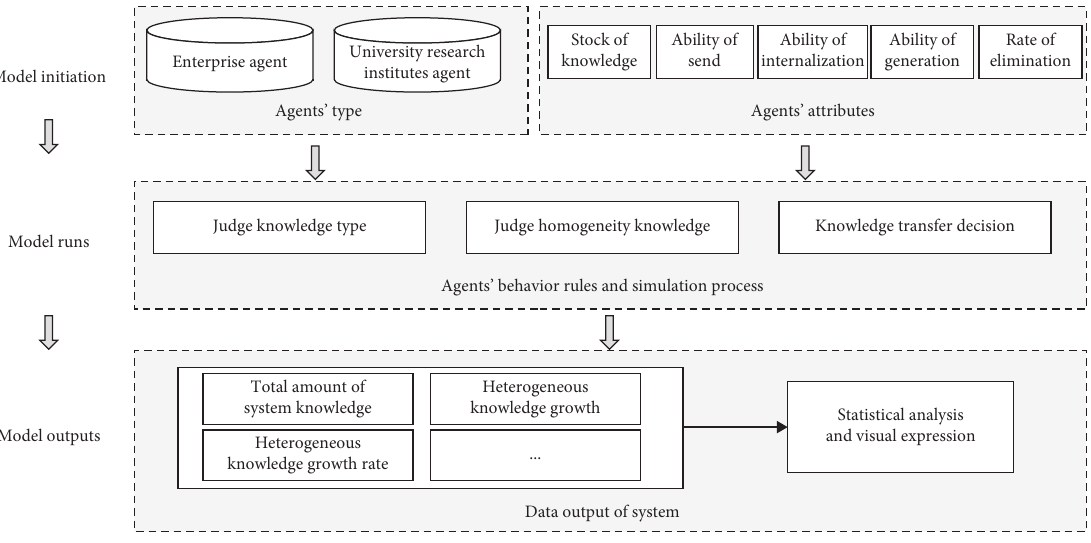
Figure 3: Simulation procedure of the agent-based model for heterogeneous knowledge increment of Table 1: Innovation subjects’ attributes parameters.